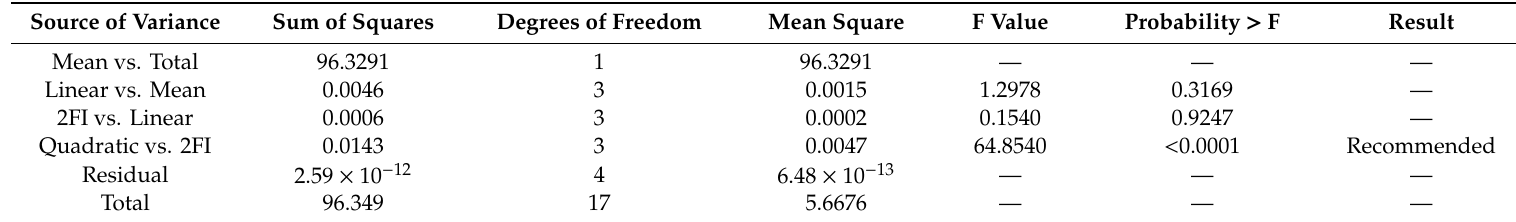
Table 11. Variance analysis of multiple models.